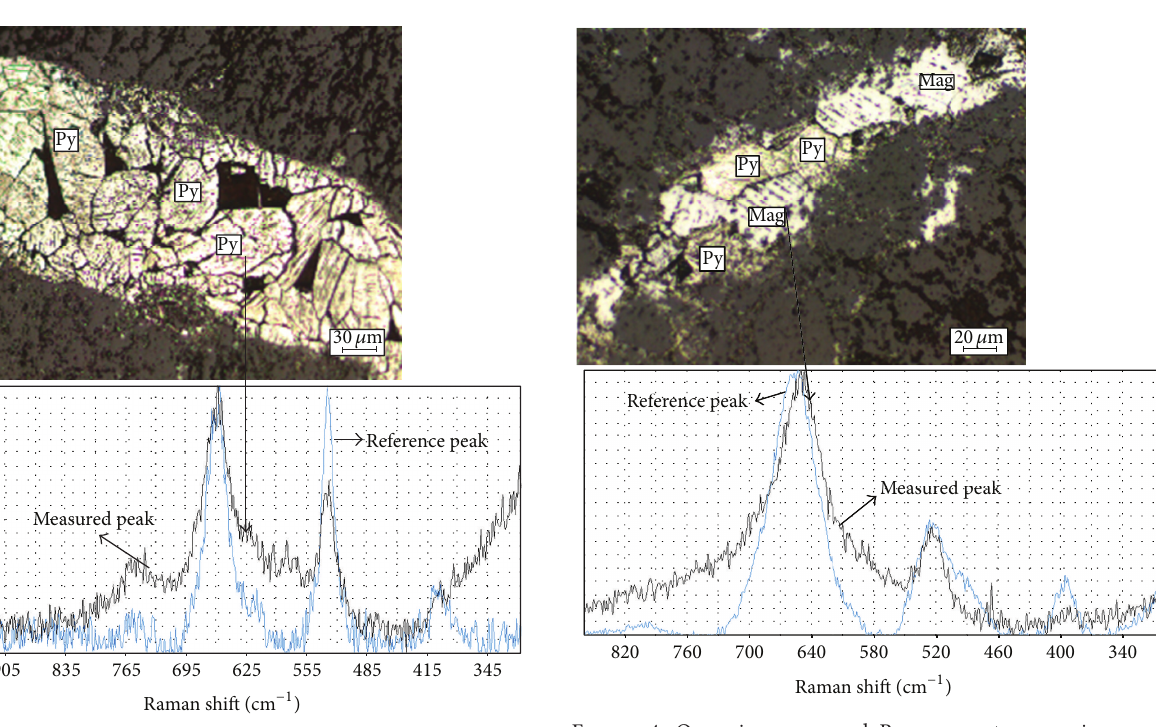
Figure 3: Ore microscopy and Raman spectroscopy images of pyrolusite.